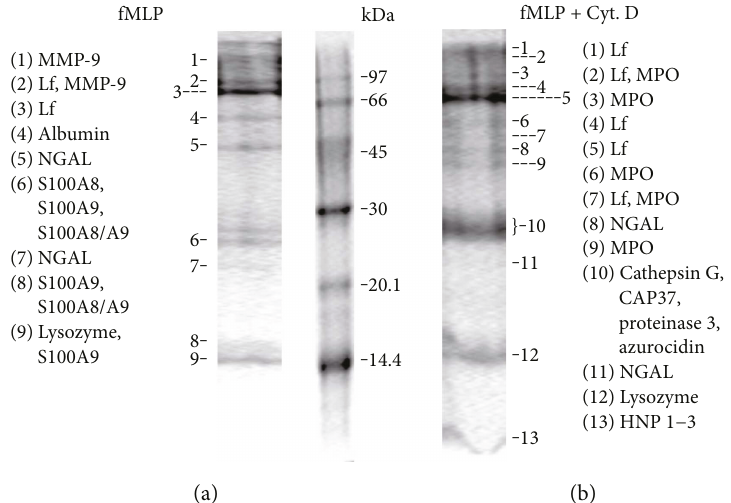
Figure 4: SDS-PAGE separation of proteins secreted by neutrophils upon adhesion to fi bronectin in the presence of fMLP and cytochalasin D. Human neutrophils were attached to fi bronectin-coated substrata for 20min in the presence of 1 μ M fMLP taken separately (a) or in combination with 10 μ M cytochalasin D (b). Samples of extracellular medium were collected and proteins were extracted and, after concentration, were subjected to 15% SDS-PAGE. The gels were stained with Coomassie Brilliant Blue. The lines mark the places from which pieces of gel were cut. In these pieces, after trypsin hydrolysis directly in the gel, the designated proteins were detected by mass spectrometry. Pictures represent typical protein pro fi les, observed in three independent experiments for each EM